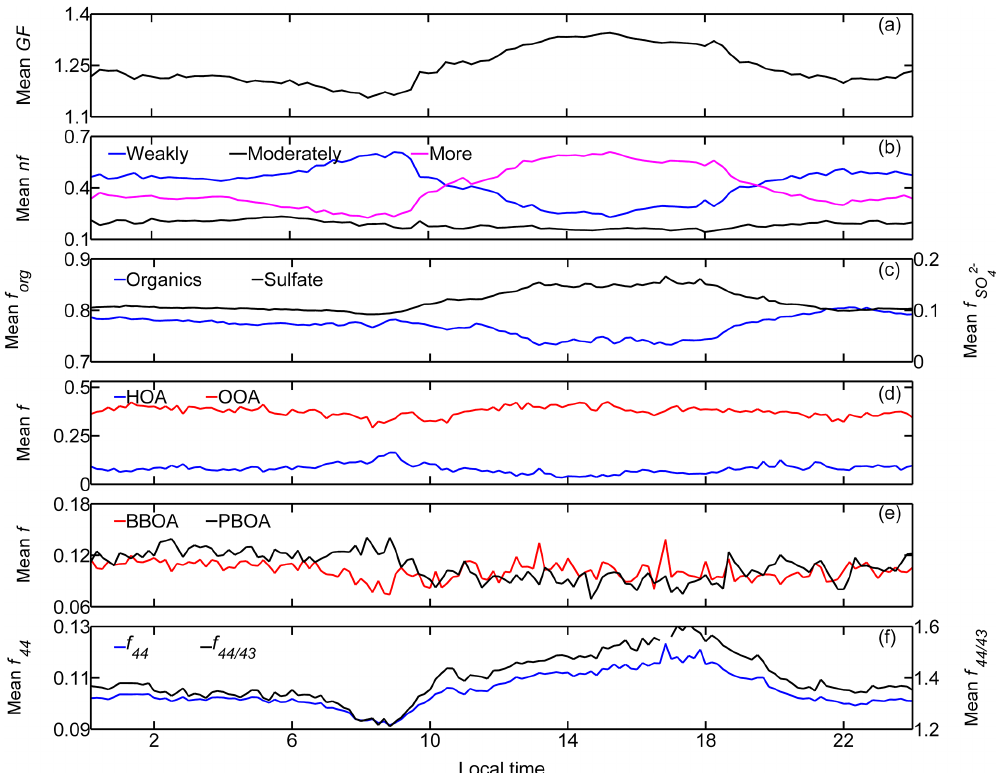
Figure 6. Temporal averaged (10–24 October 2015) diurnal variations of (a) the mean GF; (b) number fraction (nf) of the three hygroscopic modes; (c) mass fraction of the two main components in NR-PM 1 , i.e., organics ( f org ) and sulfate ( f 2 − resolved four OA factors in NR-PM 1 (i.e., f HOA , f OOA , f BBOA , and f PBOA ); and (f) mean f 44 and f 44 / 43 of organics in NR-PM 1 (local time, LT). Pronounced diurnal patterns were observed for the mean GF, number fractions of both weakly and more hygroscopic modes, f 44 , f 44 / 43 , and mass fractions of organics and sulfate as well as HOA and OOA; nf more , f 2 − to that of the mean GF, whereas contrasting diurnal patterns were found for nf weakly , f org , and f HOA .